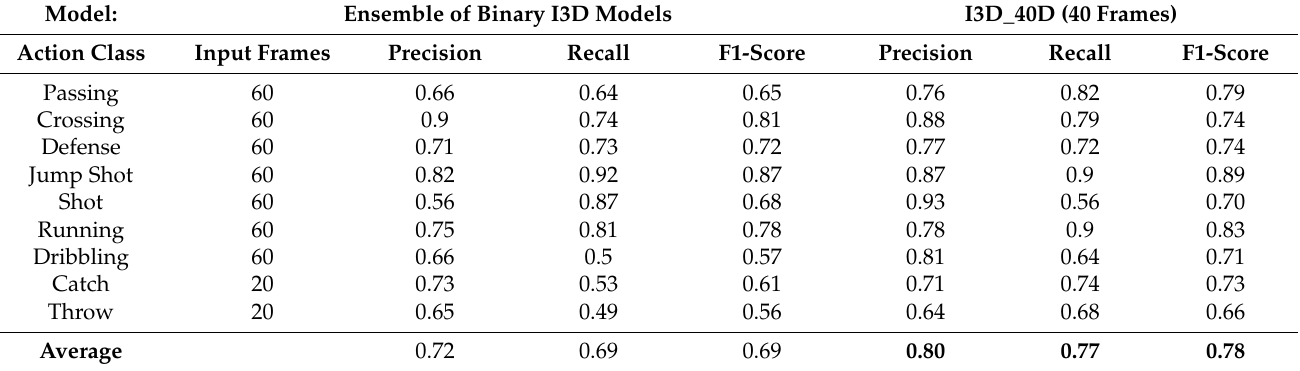
Table 5. Action recognition results for ensemble of binary I3D models and multi-class classifier I3D_D with 40 input frames on UNIRI-HBD_v2 dataset. The best average result achieved by the models on the test set is shown in bold.